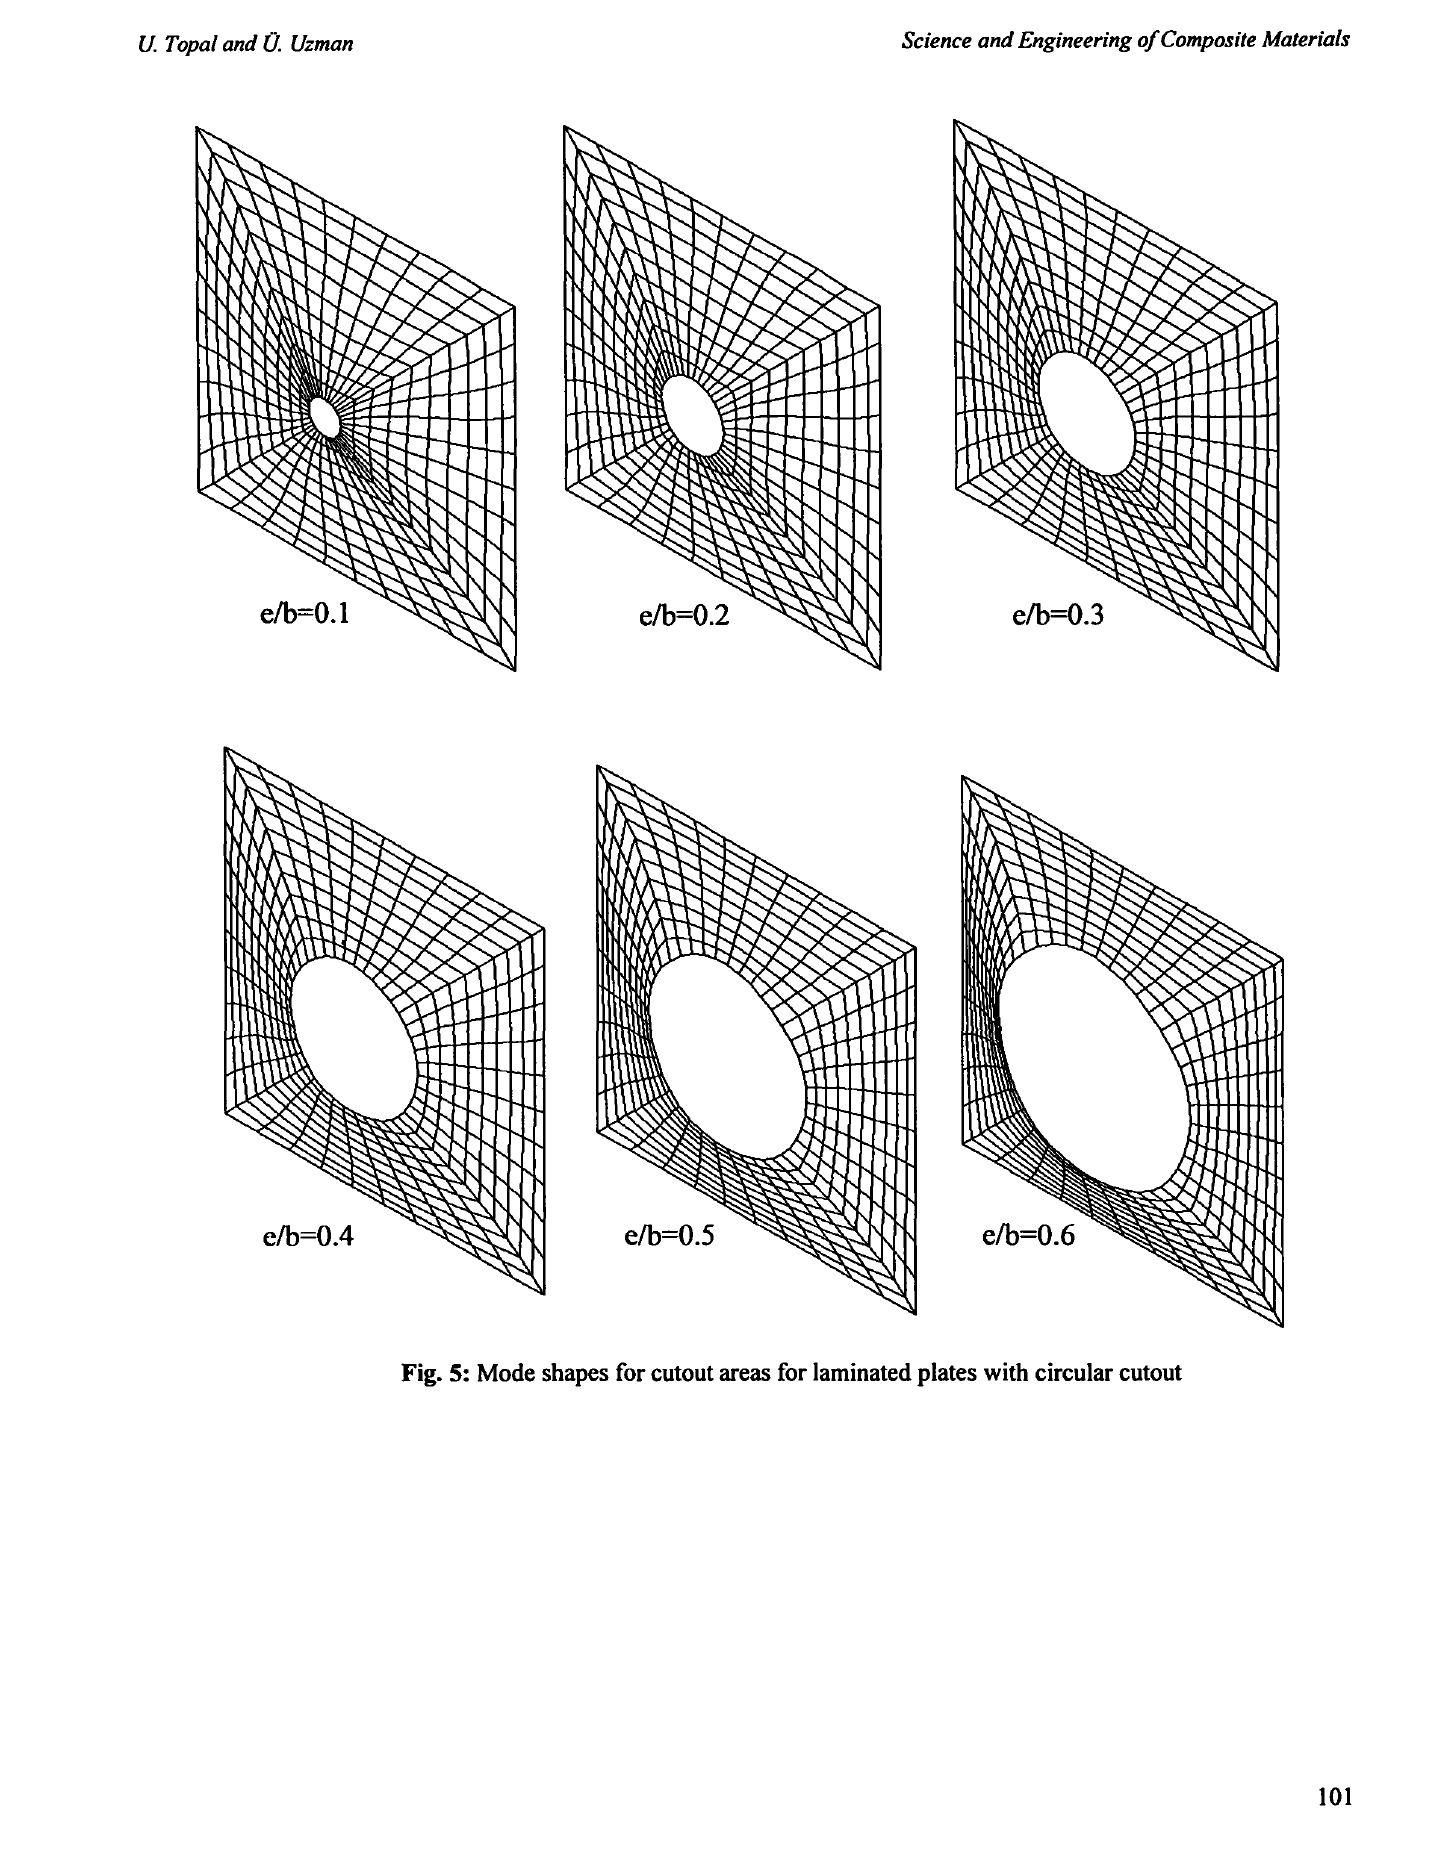
Fig. 5: Mode shapes for cutout areas for laminated plates with circular